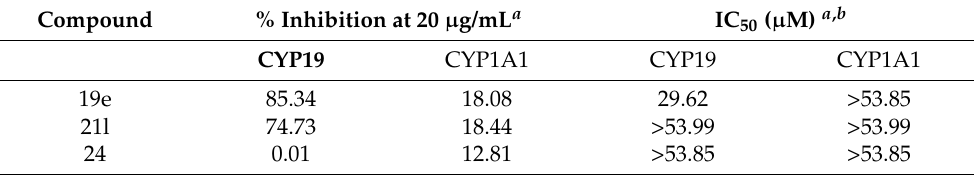
Table 5. Inhibitory effect of compounds 19e , 21l , and 24 on aromatase and CYP1A1 activity.